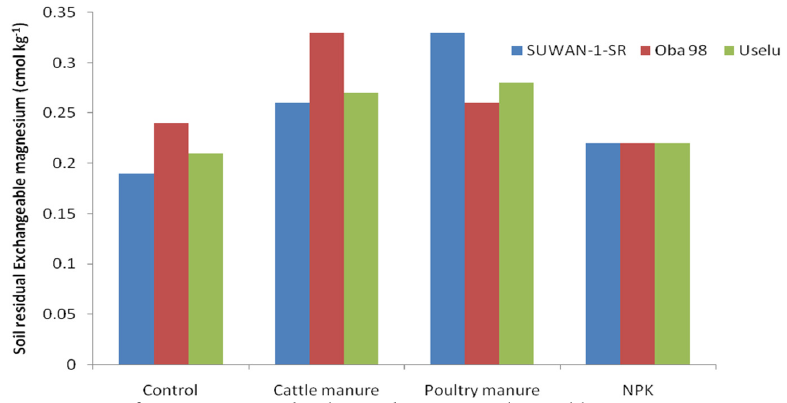
Figure 3. Interaction of maize variety and soil amendment on exchangeable magnesium